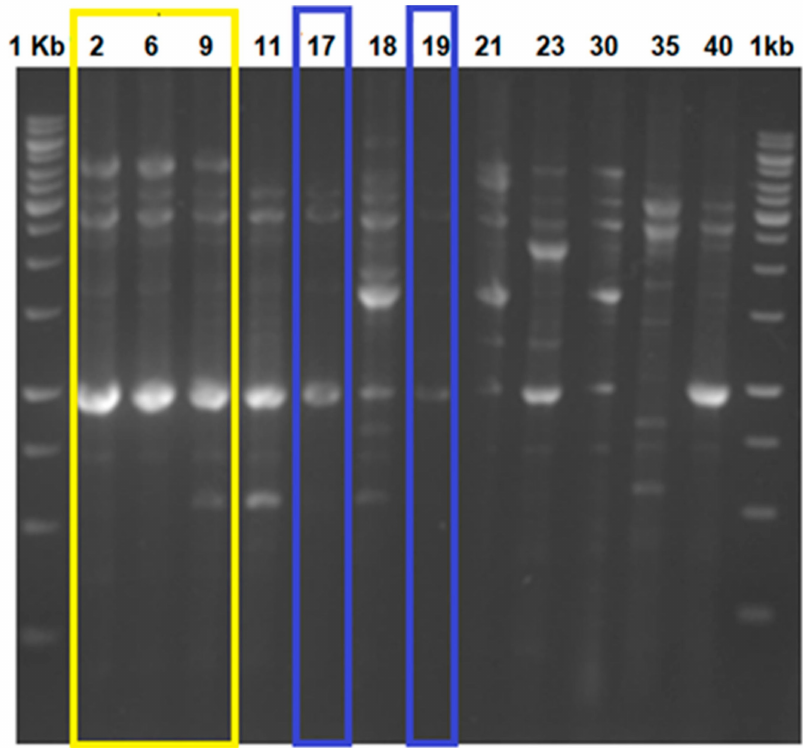
Figure 1. Fingerprints of the collected VRE strains from clinical origin. RepPCR was used to differentiate the strains and discard those belonging to the same group (colored boxes). The 1 kb ladder is from